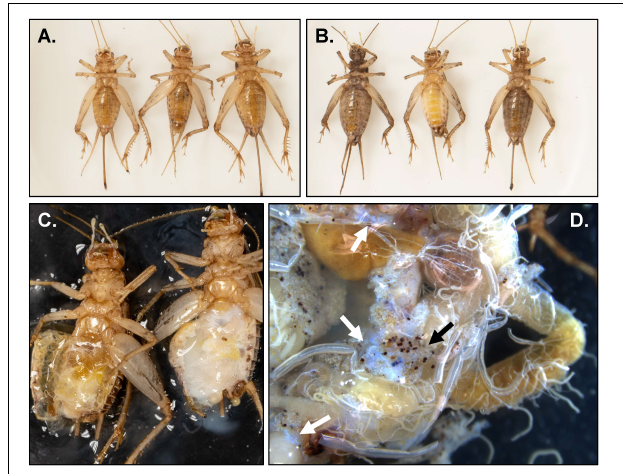
FIGURE 1 | Micro- and macroscopic images of pathology discovered in adult Gryllodes sigillatus . (A) Ventral view of crickets from the Healthy population with no apparent signs of infection (from left to right: female, male, female). (B) Ventral view of crickets from the Diseased population with clear signs of infection (from left to right: female, male, female). (C) Ventral view of hemocoel of male crickets from the Healthy (left) and Diseased (right) populations. (D) Dissected guts from a female from the Diseased population. Note the presence of nodules (black arrow) as well as the characteristic iridescent sheen (white